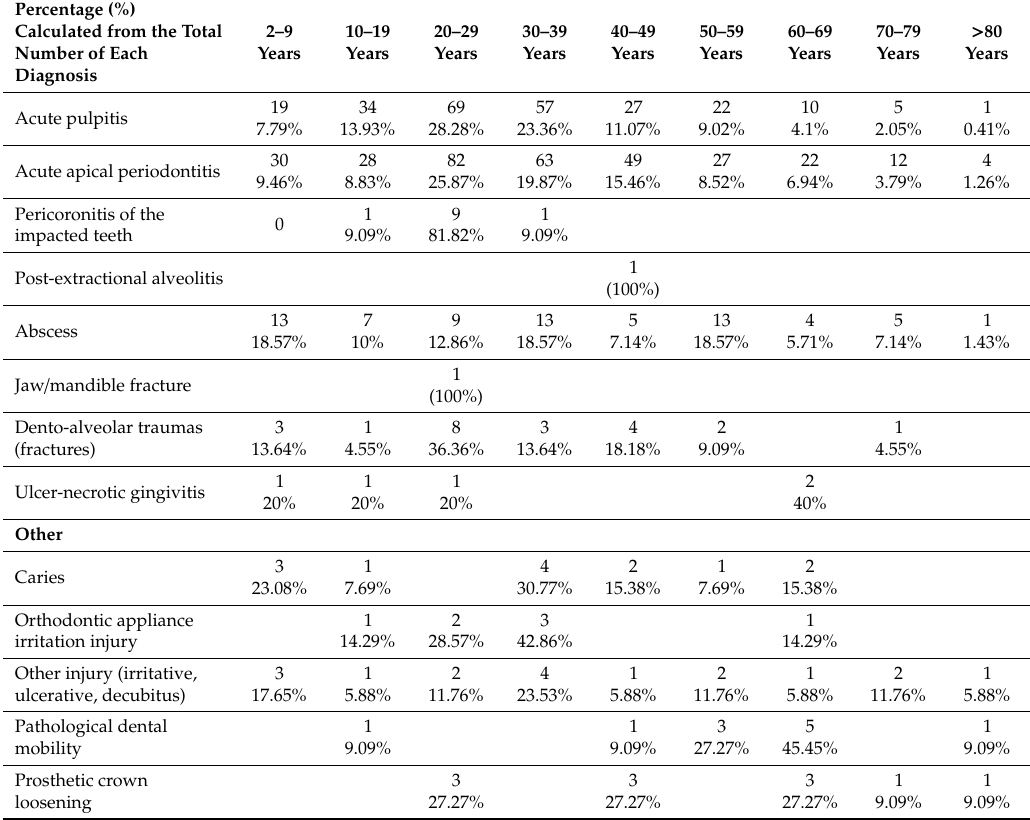
Table 2. Dental pathology distribution according to age groups during April